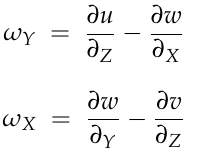
Figure 14. ( A ): Y-vorticity (𝜔 𝑌 ) contours, ( B ): approximate boundaries of the HV vortex at flat-bed conditions.